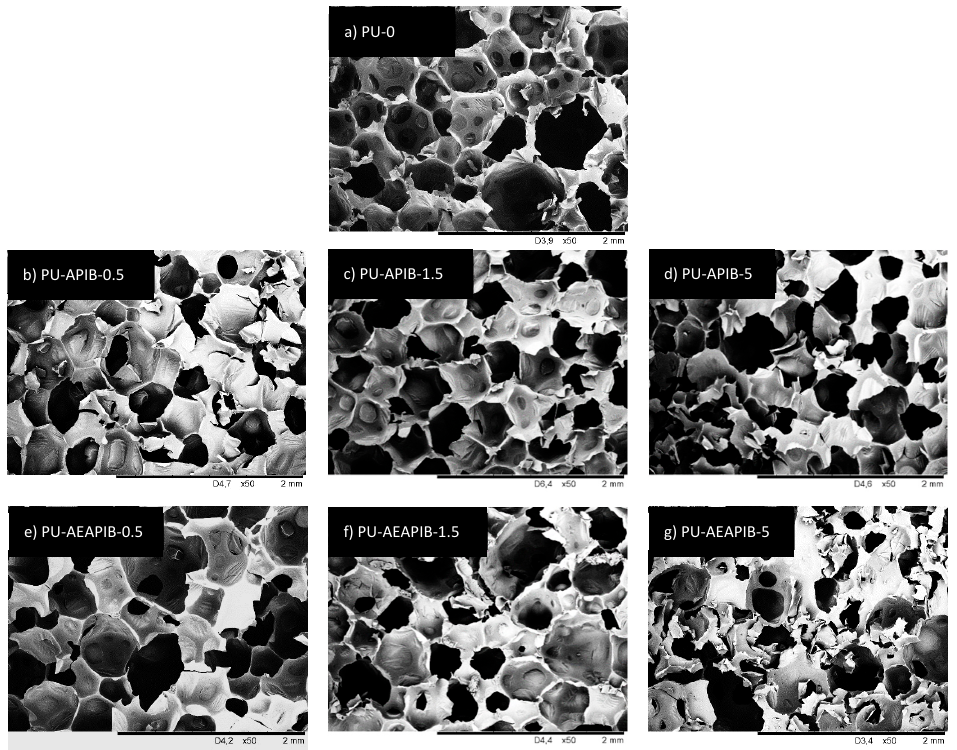
Figure 5. Morphology of ( a ) PU-0, ( b ) PU-APIB-0.5, ( c ) PU-APIB-1.5, ( d ) PU-APIB-5, ( e ) PU-AEAPIB-0.5, ( f ) PU-AEAPIB-1.5, and ( g ) PU-AEAPIB-5 observed at the same magnification.